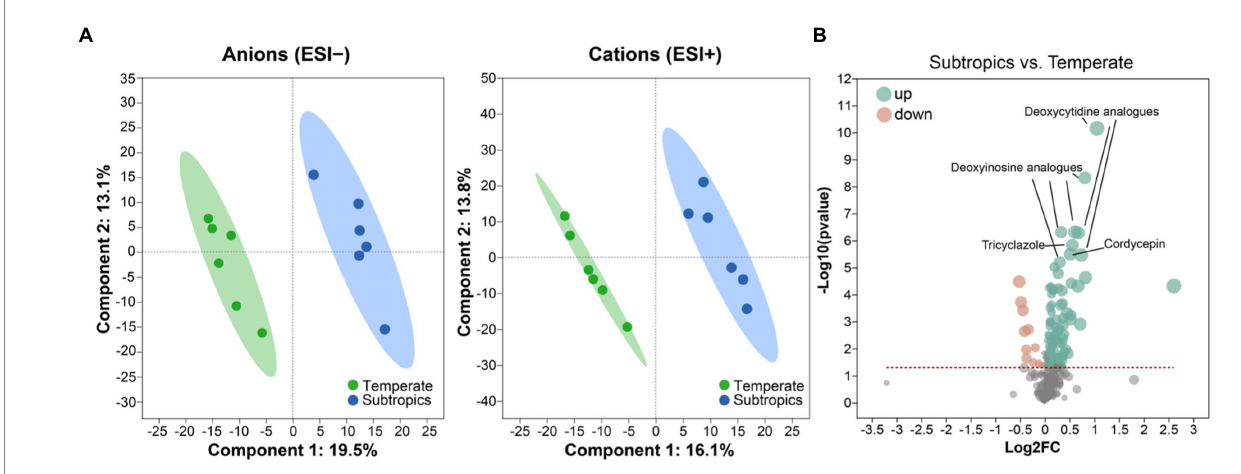
FIGURE 1 (A) Partial least squares discriminant analysis (PLS-DA) plots of the soil metabolites. (B) Volcano plot of differential metabolites between subtropics and temperate. Green dots represent a significantly upregulated expression when comparing subtropical to temperate samples; pink dots represent a significantly downregulated expression when comparing subtropical to temperate samples.